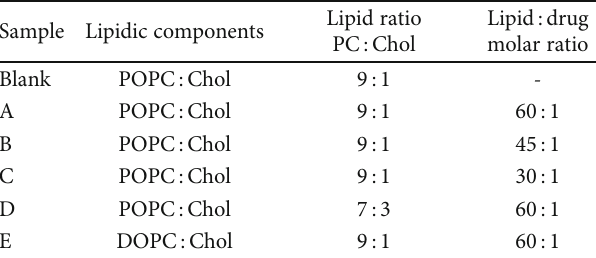
Table 1: Experimental design for the optimization of liposomes ’ lipid composition and lipid :drug ratio (concentration of everolimus was maintained at